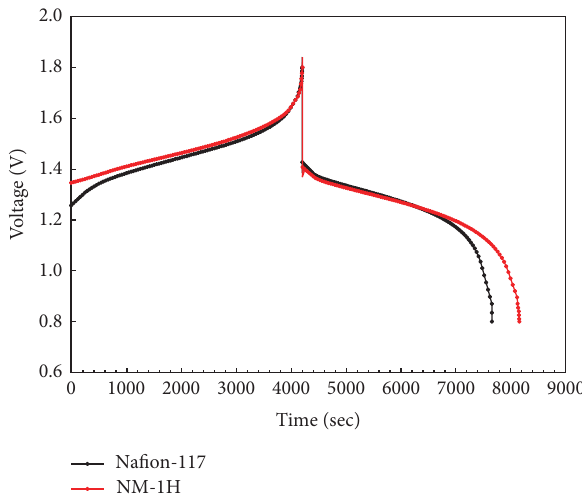
Figure 10: Charge-discharge curves of single cell performance for VRFB by N-117 and NM-1H membrane, respectively, as a separator; a current density is 20 mA cm −2 .